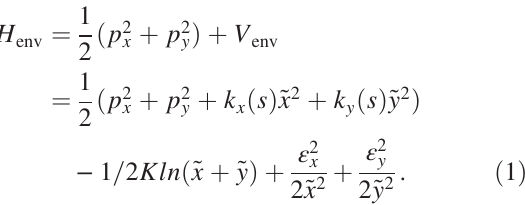
and momentum βγ ¼ 0 . 0178818 . A number of 30 K